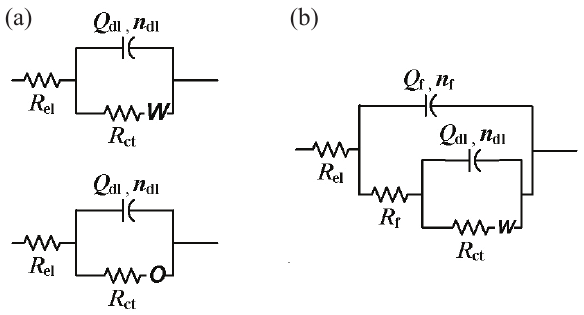
Fig. 6 – Equivalent electrical circuits used for fitting the EIS spectra of (a) blank, and (b) ODPA-treated samples